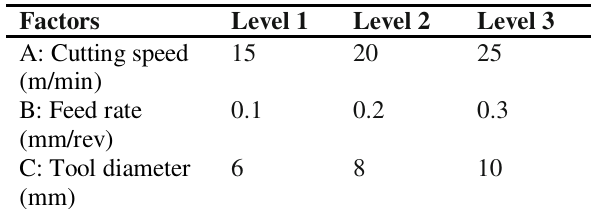
Experimental factors and levels